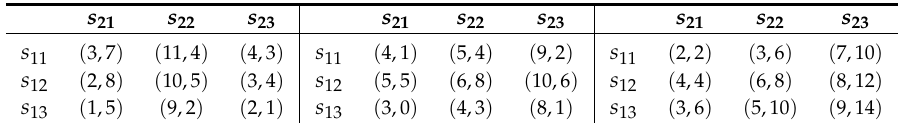
Table 10. Utilities for basic games G 1 , G 2 and G 3